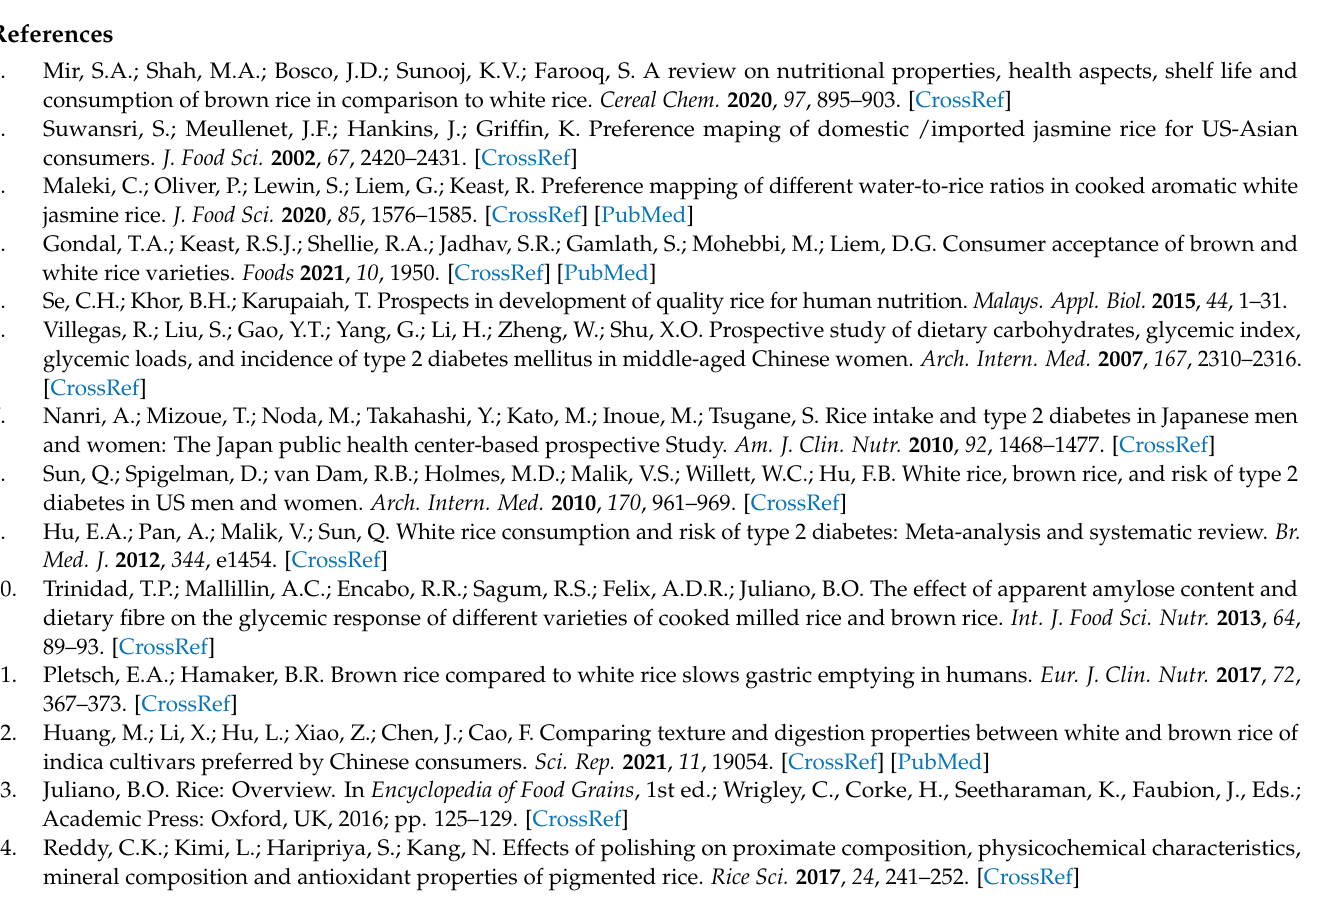
Table S1: Rice bran traits of whole grain rice samples; Table S2: Physical characteristics of whole grain rice samples; Table S3: Chemical compositions of whole grain rice samples; Table S4: Chemical compositions of milled bran samples; Table S5: Pearson’s correlation matrix; Table S6: Texture profile analysis of cooked whole grain rice samples; Table S7: Genotype of rice samples; Table S8: Range of basic nutrient compositions of whole grain rice, milled rice, and rice bran; Table S9: Comparison of the β -glucan and pectin content in whole grain rice and rice